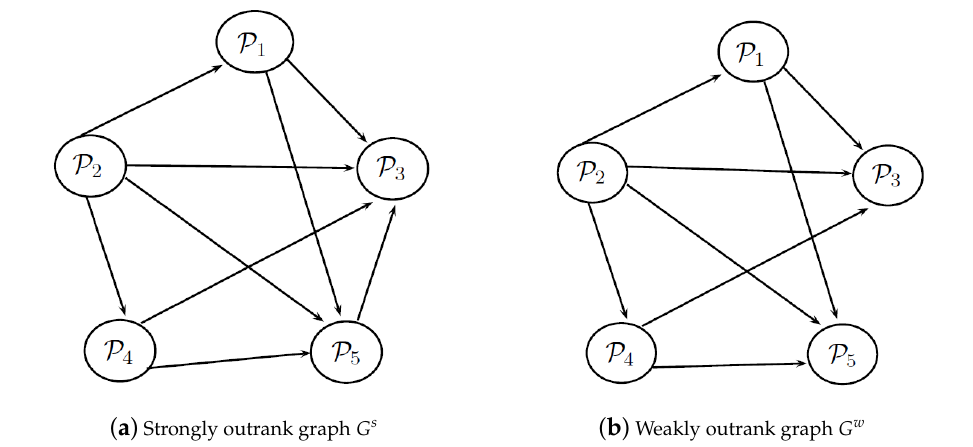
Figure 1. Graphical representation of outranking relations between alternatives.